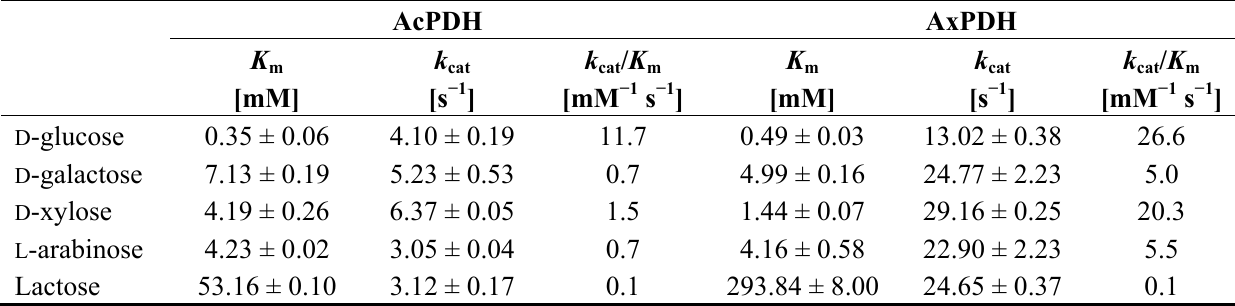
Table 3. Apparent kinetic constants for selected electron donors determined at 30 °C with 0.2 mM ferrocenium hexafluorophosphate as the electron acceptor.